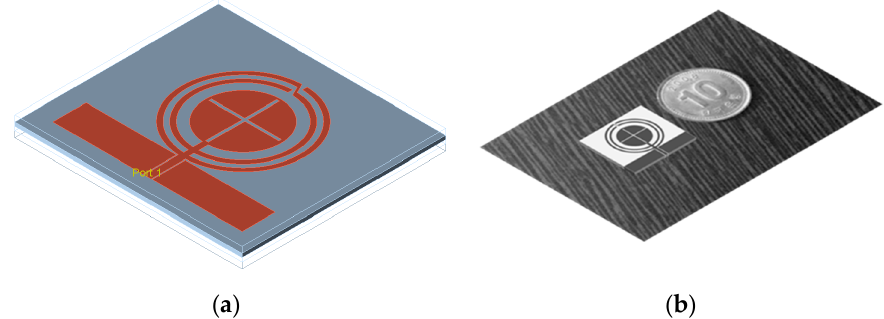
Figure 3. Proposed slotted small loop antenna with its ( a ) isometric view and ( b ) fabricated view.